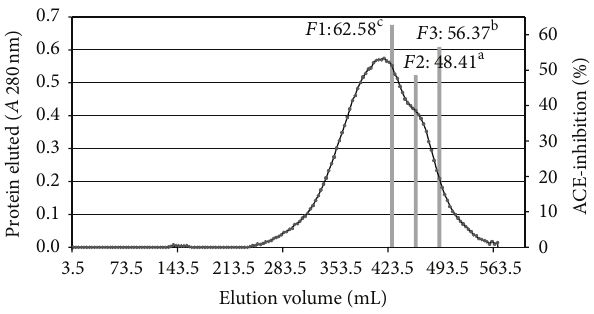
Figure 3: Elution profile of the < 1kDa ultrafiltration fraction of the S. hispanica protein hydrolysate purified in a Sephadex G-50 gel filtration column. a–e Different superscript letters indicate statistical difference ( 𝑃 < 0.05 ). Data are the mean of three